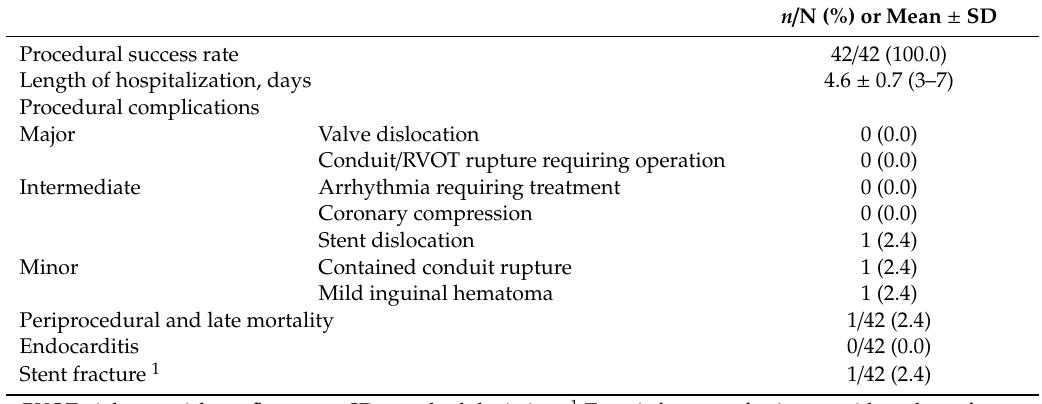
Table 3. Procedural